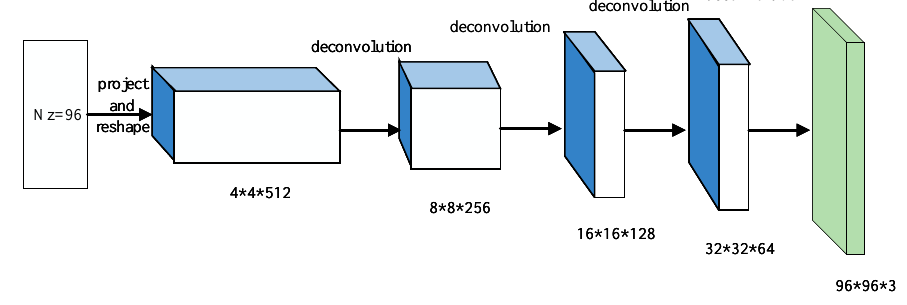
Figure 3. Construction of generative model.